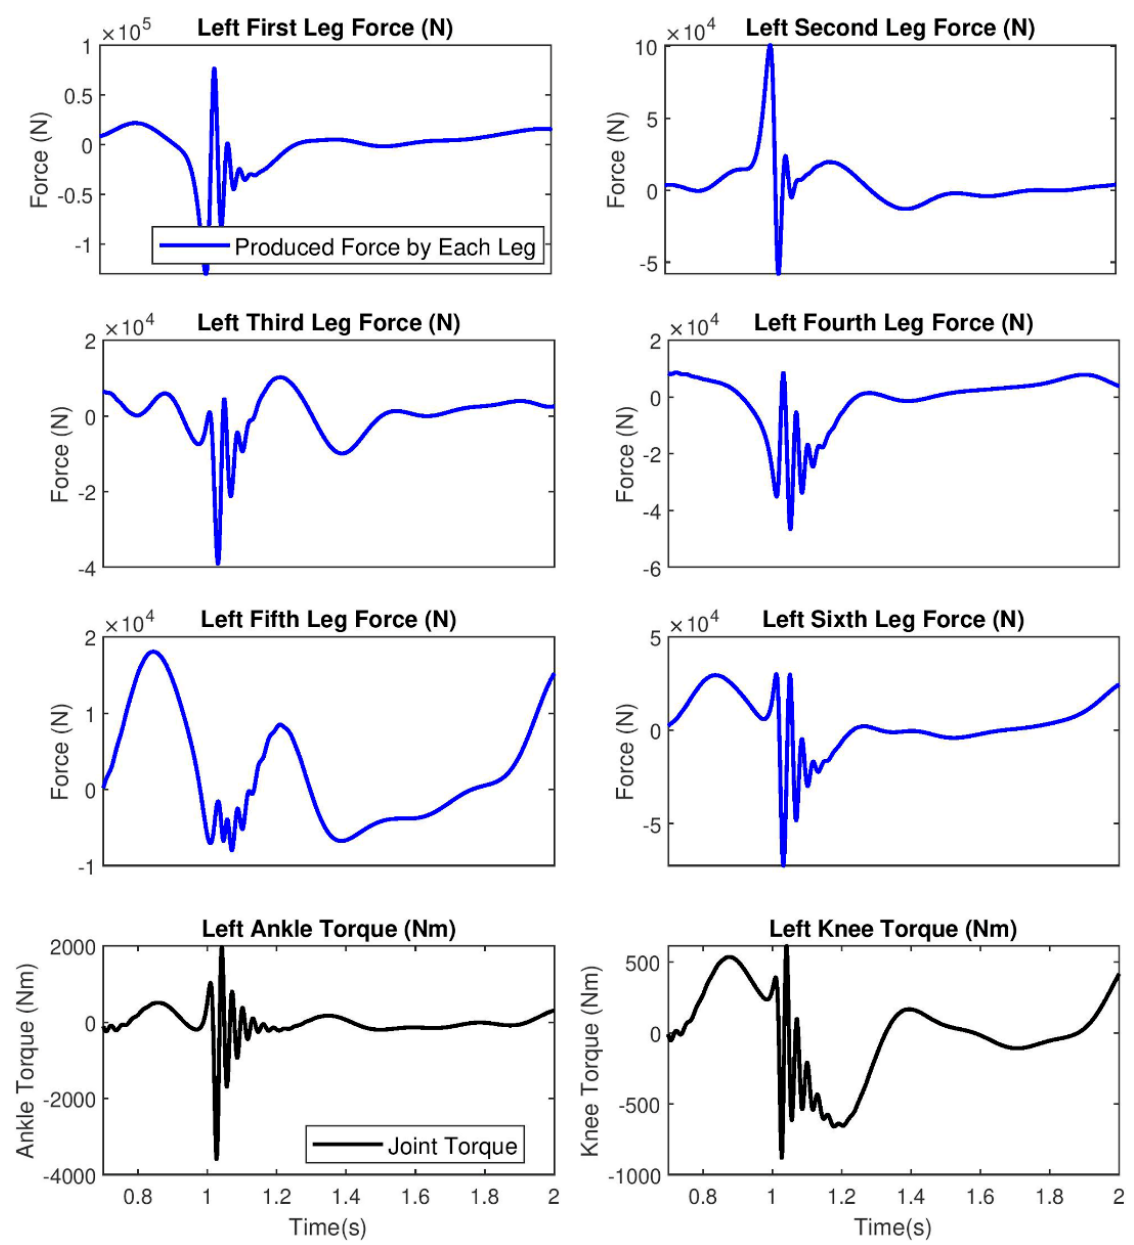
Figure 4. The left Stewart leg forces as well as the left ankle and knee torques. The 1st, 2nd, 3rd, 4th, 5th, and 6th leg length errors versus time for the left legs were